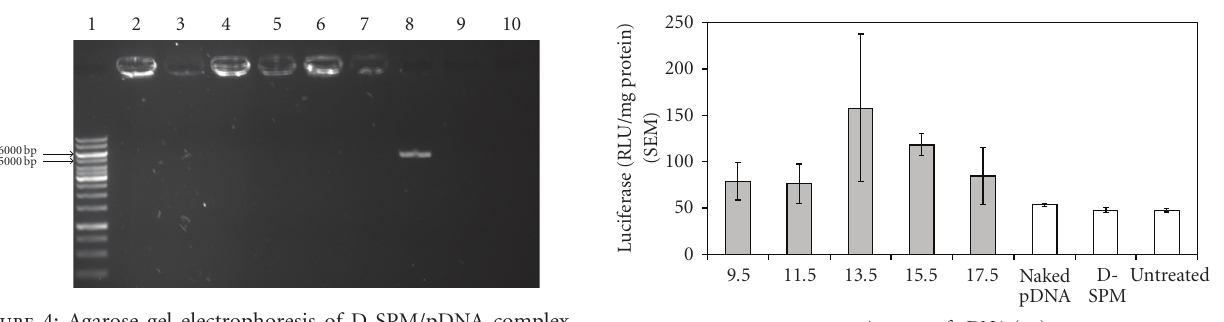
Figure 4: Agarose gel electrophoresis of D-SPM/pDNA complex at di ff erent ratios following DNase treatment. Lane 1: 1 kb DNA ladder; 2, 4, and 6: D-SPM complexes at ratio 14, 16, and 18, respectively; 3, 5, and 7: D-SPM/pDNA complexes at ratio 14, 16, and 18, respectively, treated with DNase I; 8: free pDNA; 9: free pDNA treated with DNase I; 10: D-SPM only.